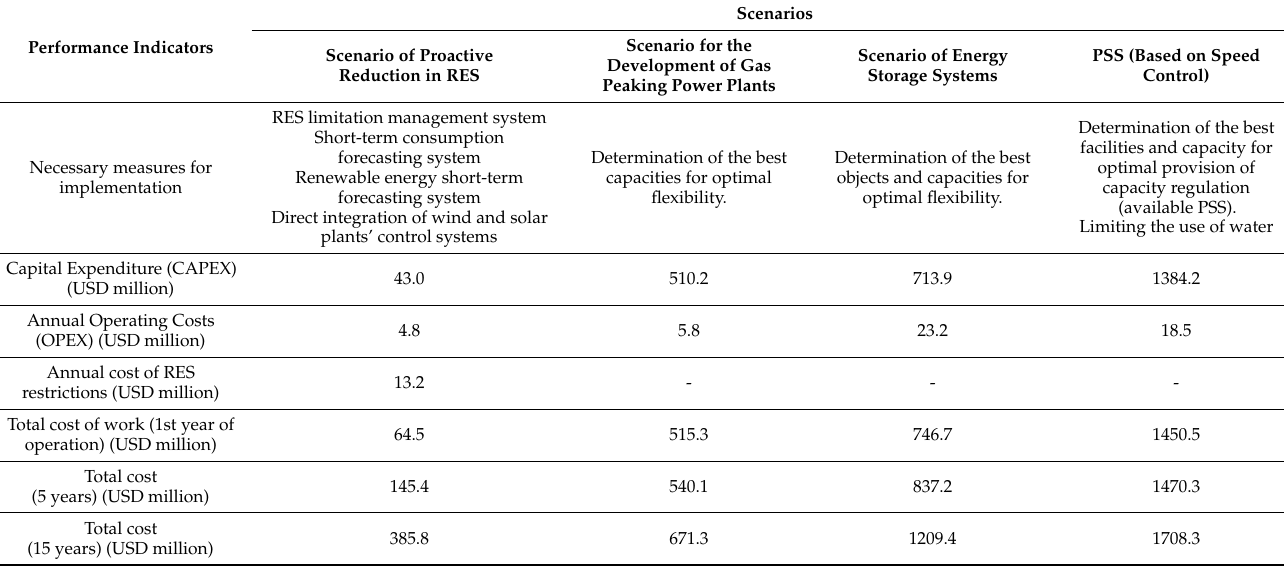
Table 2. Results of economic analysis (assessment) of the flexibility of implementing projects for the development of the corporate renewable energy.